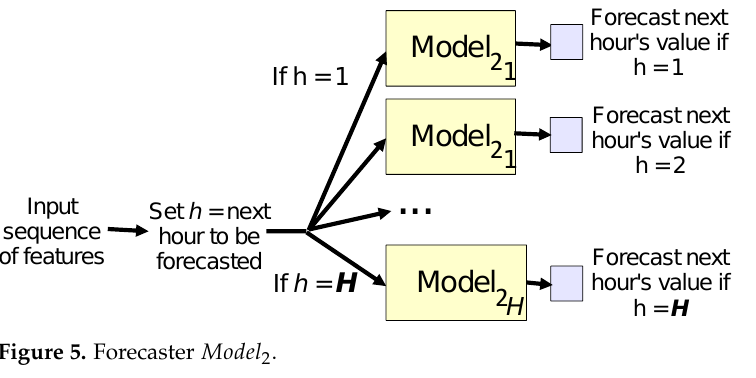
Figure 5. Forecaster Model 2